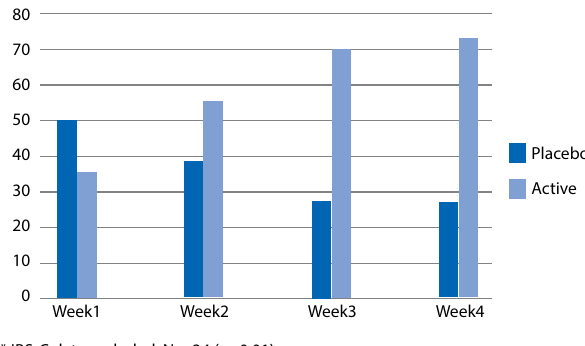
Figure 2: Percentage Patients Who Experienced Adequate Relief (IBS-C excluded)